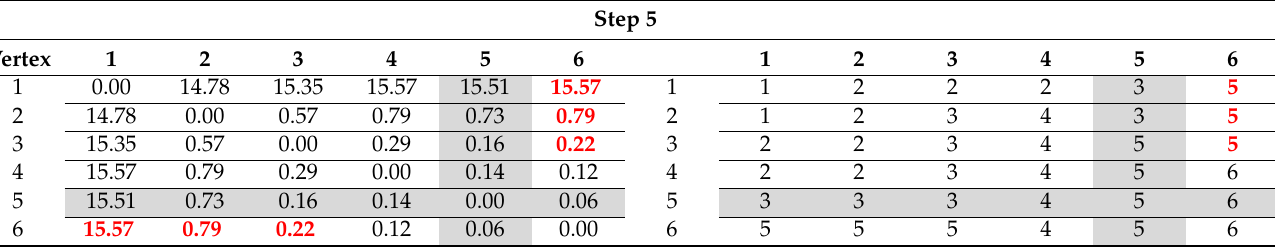
Table A5. The step 5 graphical process of Floyd–Warshall